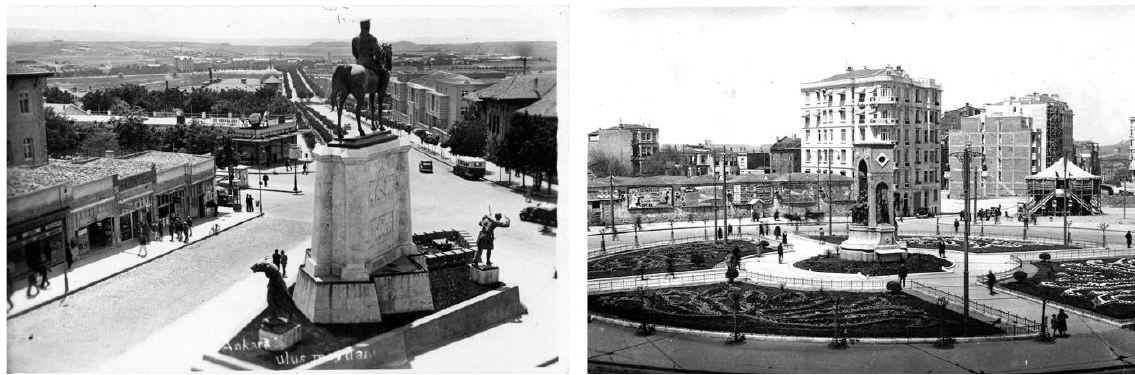
Figure 1 Monuments marking the public space of modern Turkey: public art to aestheticize the national identity in the making (Source: URL-1,